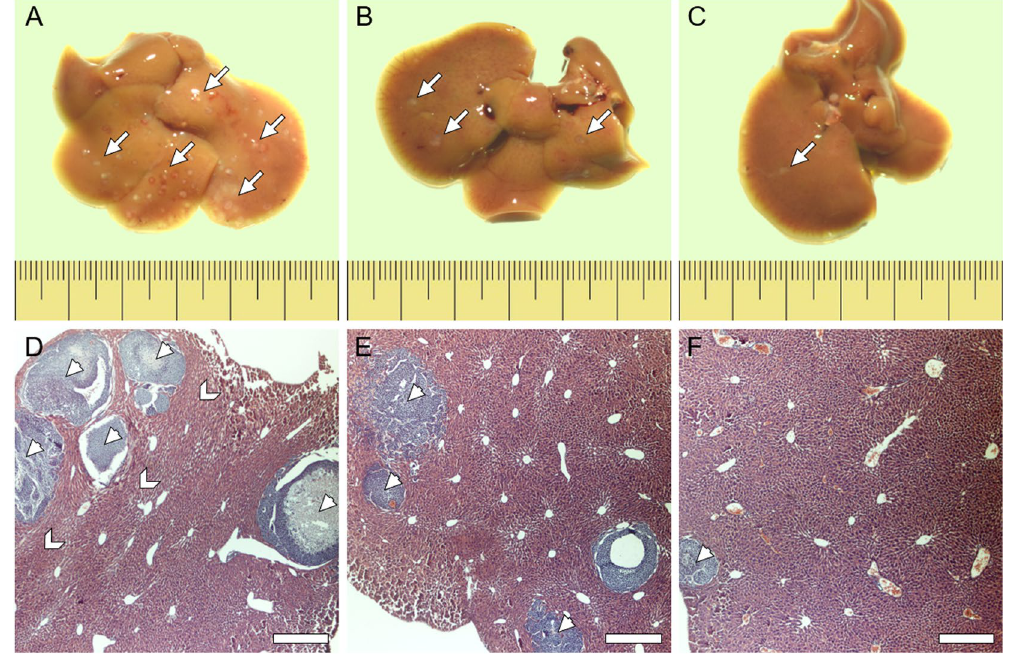
Figure 4. Tissue samples with metastatic tumors isolated from mice. Liver samples isolated from mice, which had inoculated melanoma cells with different levels of melanin pigmentation: non-pigmented ( A , D ), moderately-pigmented ( B , E ) and heavily-pigmented ( C , F ). Upper row images show entire livers, whereas lower row images show histological samples of the livers. Arrows in the upper row images indicate the locations of metastatic colonies, whereas arrow heads in the lower row images indicate individual tumors. Note the morphology of the lobules of livers in the case of mice inoculated with non-pigmented melanoma cells is much more compact than in the case of mice inoculated with pigmented cells, indicating higher tissue density. Higher tissue compaction is indicated by chevrons. Scale pitch on the rulers represents one millimeter, whereas scale bars represent 200 μ